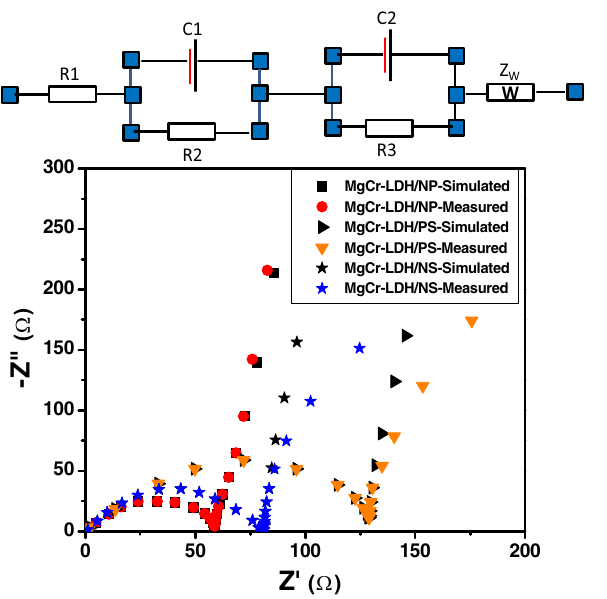
Figure 7. Electrochemical impedance spectra of the measured and simulated data of the as-synthesized MgCr- LDH/PS, MgCr-LDH/NS and MgCr-LDH/NP